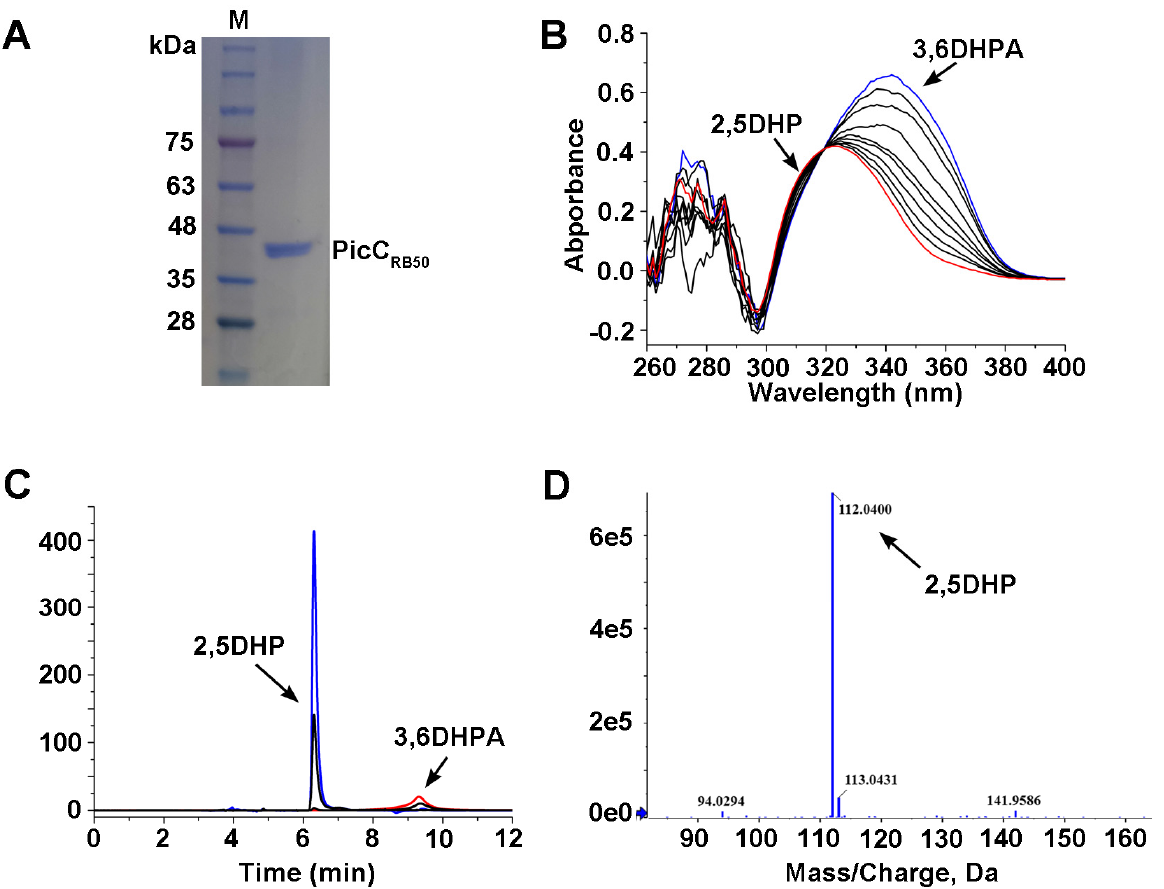
Figure 3. Purification and identification of PicC RB50 . ( A ) SDS − PAGE analysis of purified PicC RB50 . Figure 3. Puri fi cation and identi fi cation of PicC RB50 . ( A ) SDS − PAGE analysis of puri fi ed PicC RB50 . Lane M, protein marker. A single bond of puri fi ed PicC RB50 was indicated. ( B ) Spectrophotometric Lane M, protein marker. A single bond of purified PicC RB50 was indicated. ( B ) Spectrophotometric monitor of 3,6DHPA consumption (blue) and 2,5DHP formation (red) by puri fi ed PicC RB50 . ( C ) monitor of 3,6DHPA consumption (blue) and 2,5DHP formation (red) by purified PicC RB50 . ( C ) HPLC HPLC pro fi les of 3,6DHPA consumption and 2,5DHP formation by puri fi ed PicC RB50 . ( D ) profiles of 3,6DHPA consumption and 2,5DHP formation by purified PicC RB50 . ( D ) LC/TOF − MS LC/TOF − MS pro fi le of the transformation product 2,5DHP. profile of the transformation product